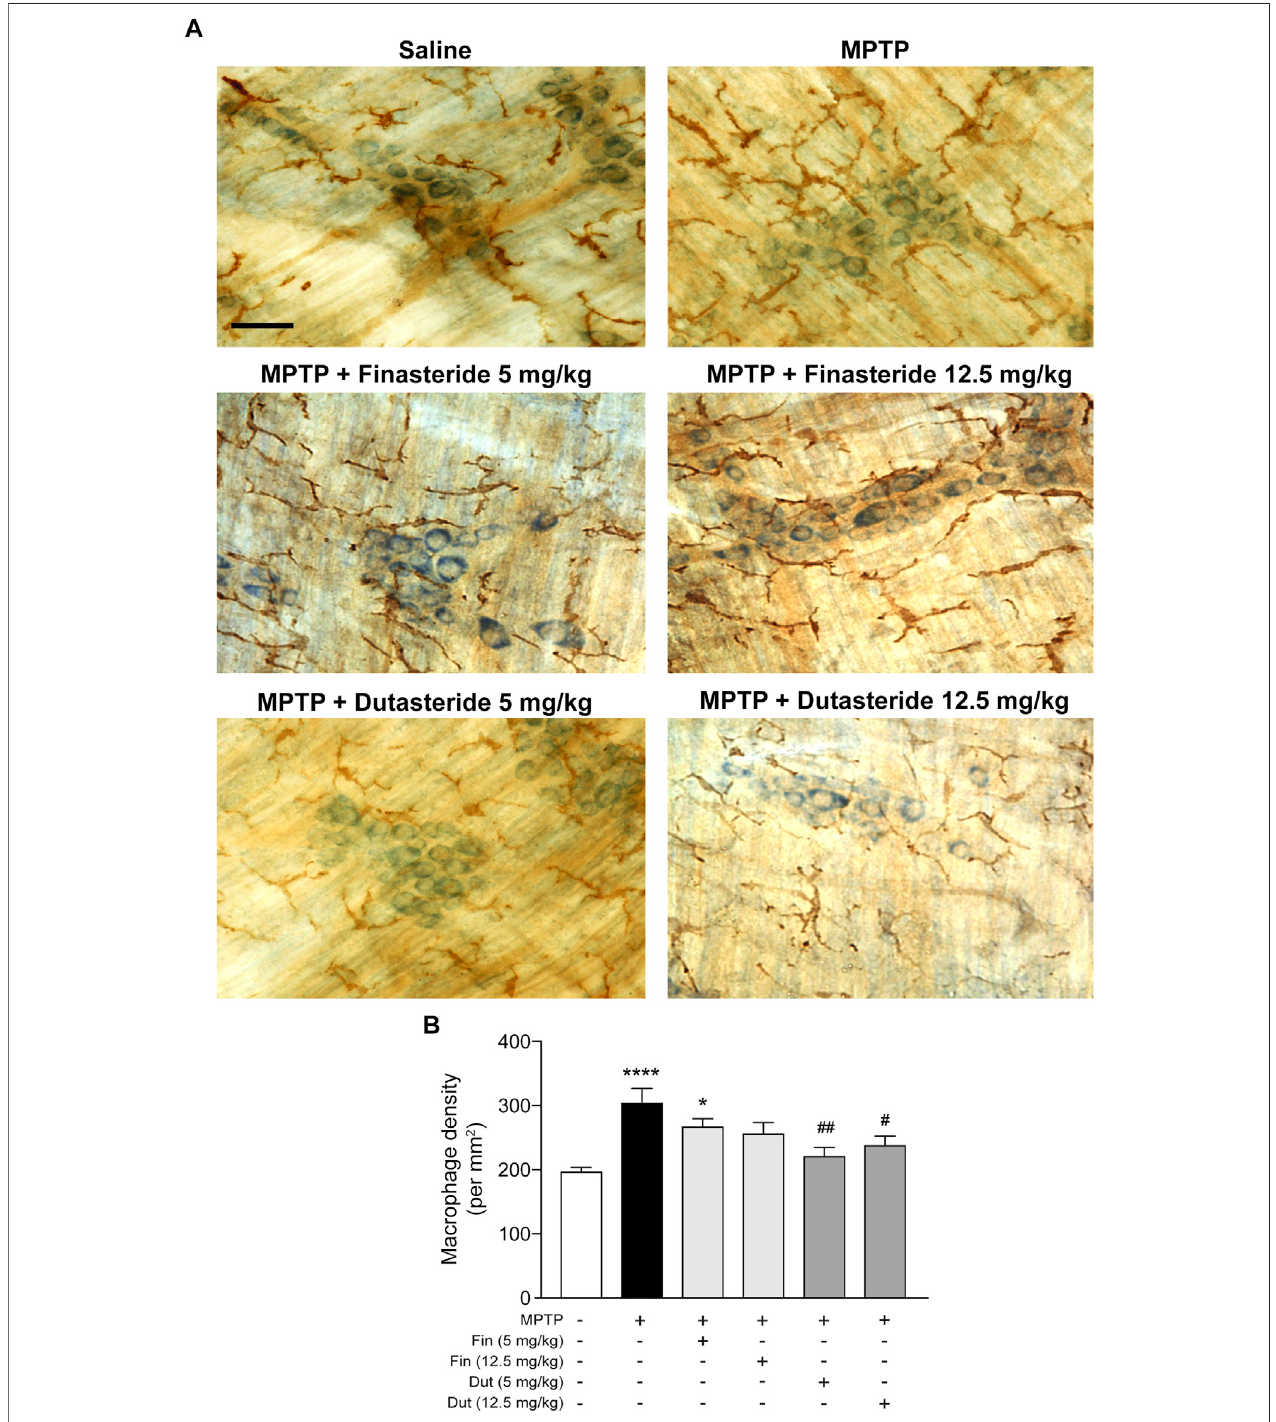
FIGURE 3 | Dutasteride treatment prevented the MPTP-induced macrophage response in the myenteric plexus, whereas fi nasteride gave an inconclusive effect. (A) PhotomicrographsofIba-1immunochemistrystaining(brownDABstaining)inthemyentericplexusofthedistalileum;scalebar=25 µm. (B) Stereologicalcountsof macrophages in the myenteric plexus showed an MPTP-induced increase in macrophage density inhibited by dutasteride (Dut) treatment (5 and 12.5 mg/kg), whereas fi nasteride (Fin) treatment at 5 mg/kg was ineffective and at 12.5 mg/kg led to no change compared to controls or vehicle-treated MPTP mice. Values shown are theaveragedensities(permm 2 )±SEMof10micepergroup.* p < 0.05and**** p < 0.0001comparedtosalinecontrolmice; # p < 0.05and ## p < 0.01comparedtoMPTP lesioned